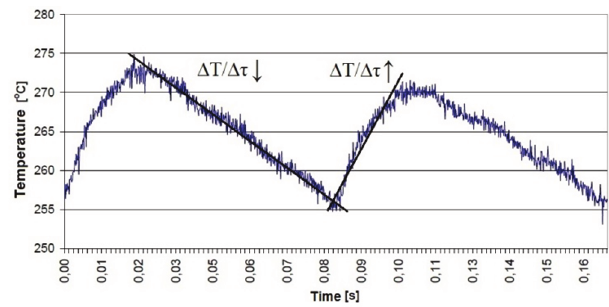
Fig. 4. The course of fluctuation of the quick-changing exhaust gas tem- perature for one engine cycle and the graphical interpretation of